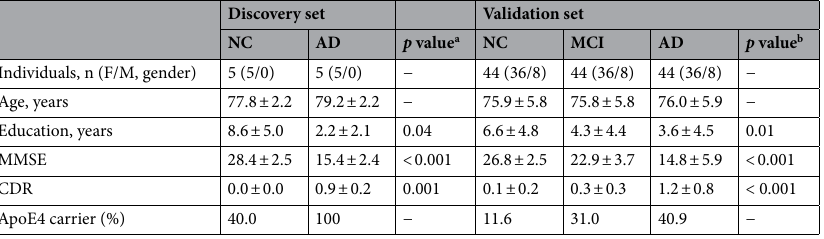
Table 3. Demographic data of study participants. Data are shown as mean ± standard deviation (SD). a Significant differences were evaluated by Independent t test. b Significant differences were evaluated by one- way ANOVA